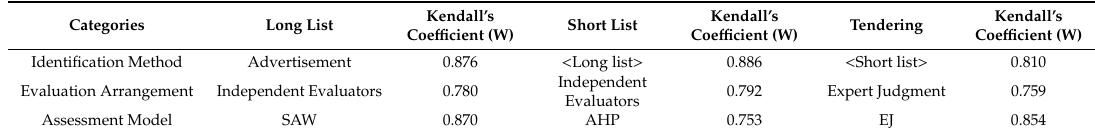
Table 9. Proposed procedures of evaluation of Construction Consultant.